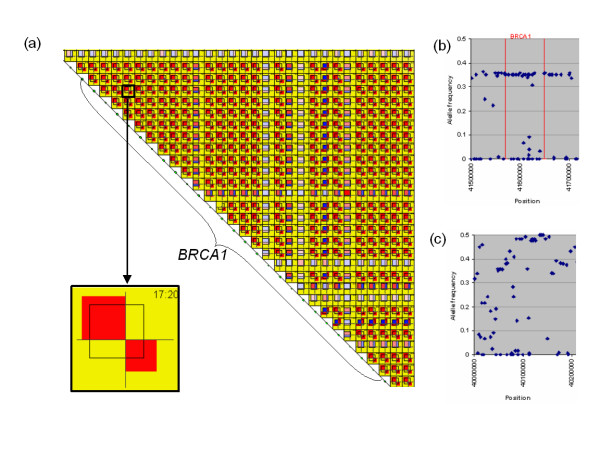
Visualisation of regions of perfect LD. Marker pairs can have either two or three haplotypes present when D' = 1. Most programs do not distinguish between these graphically, despite the potential biological importance. (a) The BRCA1 region on chromosome 17. MIDAS shows only two haplotypes for many SNPs (perfect LD, r2 = 1) using HapMap data [29,30]. (b) Allele frequencies from HapMap data [29,30] show that SNPs in regions with only two haplotypes share the same minor allele frequency (MAF) for many SNPs (eg BRCA1 region on chromosome 17) compared to (c) nearby regions which have a mixture of MAFs. Viewing MAF may therefore be a quick way to find regions of perfect LD, which can then be checked with MIDAS.